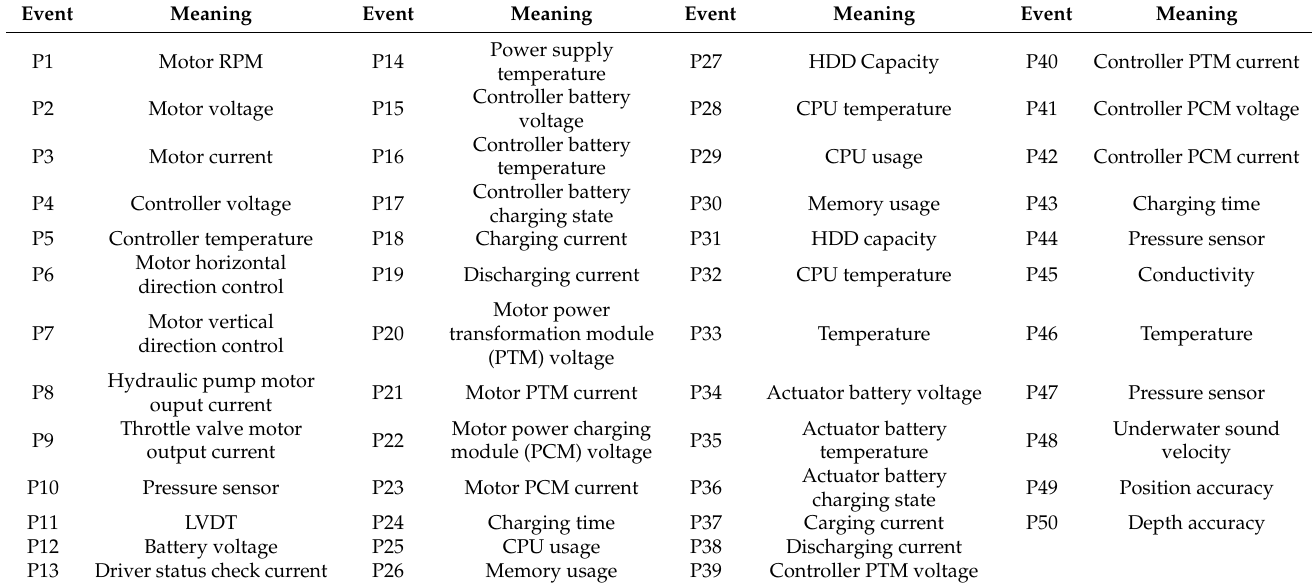
Table 1. Basic performance event description of the fault tree.